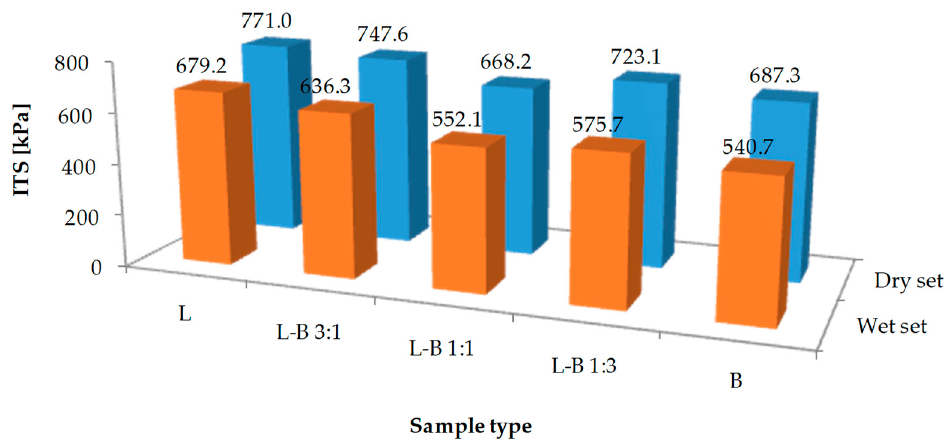
Figure 8. Indirect tensile strength of the studied mixes for the dry and wet samples.